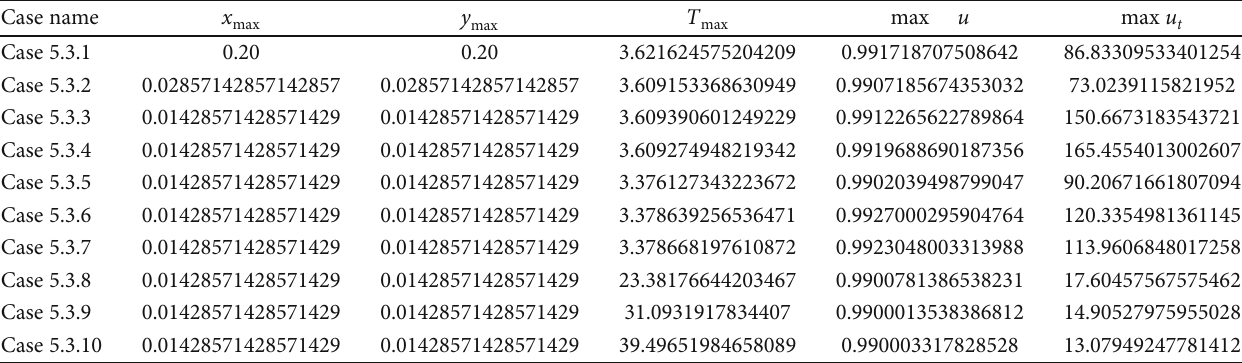
Table 5: Quenching data of α and β based on convection term b / ð 1 + α x + β y Þ .